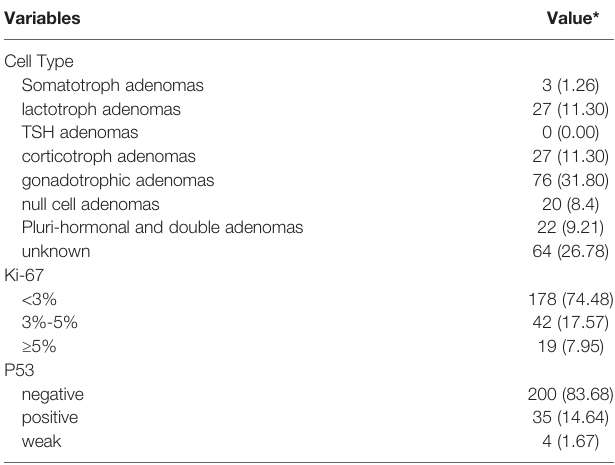
TABLE 3 | Pathological characteristics. Variables